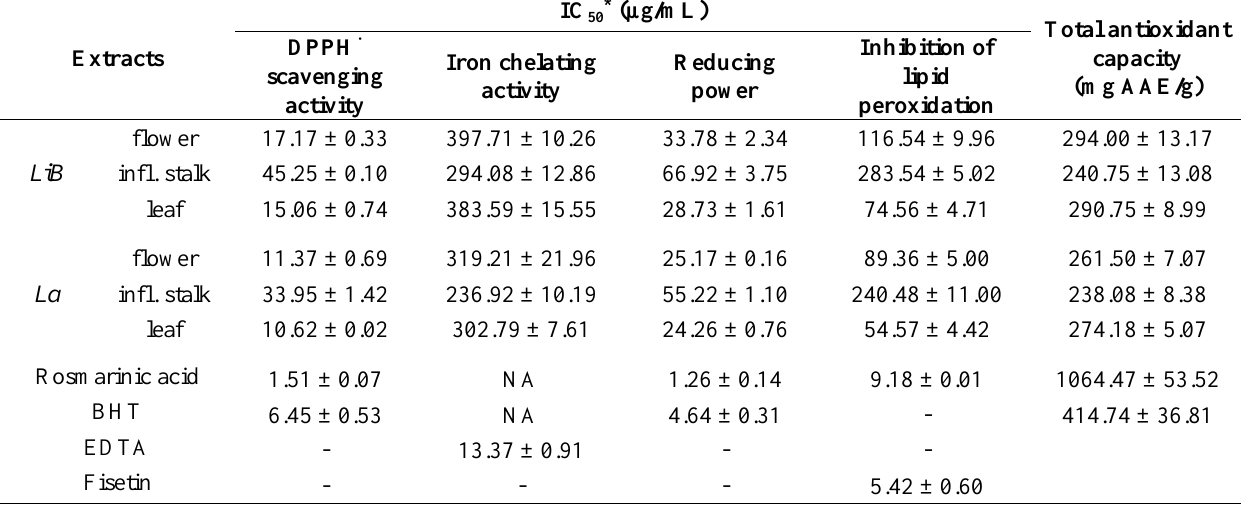
Table 2. IC values of various Lavandula x intermedia 'Budrovka' ( LiB ) and L. 50 angustifolia ( La ) extracts, their constituent rosmarinic acid and